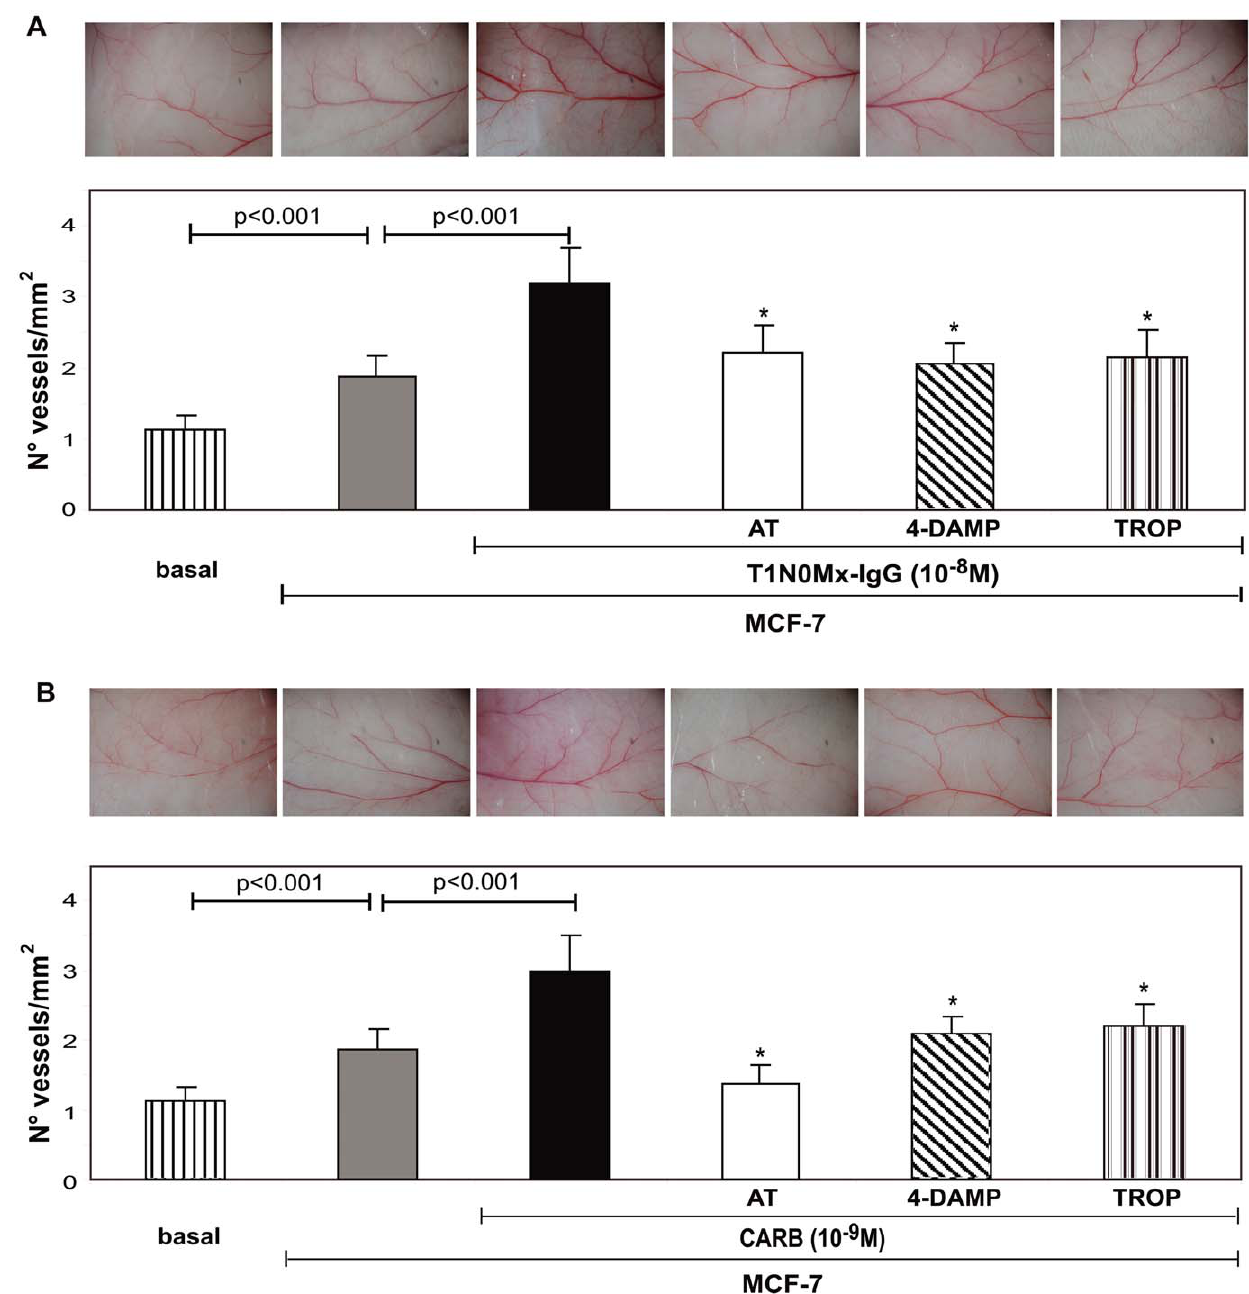
Figure 5. Effect of T1N0Mx-IgG or carbachol on MCF-7 cells-induced angiogenesis. MCF-7 cells were adjusted to 2 6 10 6 cells/ml and treated during 1 h with A) T1N0Mx-IgG (10 2 8 M) or B) carbachol (CARB) (10 2 9 M) in the absence or presence of 10 2 8 M atropine (AT), 4- diphenylacetoxi-N-methylpiperidine (4-DAMP), or tropicamide (TROP). Cell suspensions (0.1 ml) were inoculated (i.d.) in both flanks of NUDE mice. Values are means 6 S.E. of three experiments performed in triplicate. Basal: animals without treatment. p , 0.001 vs. T1N0Mx-IgG or CARB. Photographs of the angiogenic sites from each experimental group stated in A) and B) are shown in upper panels. Magnification 6.4 6 .